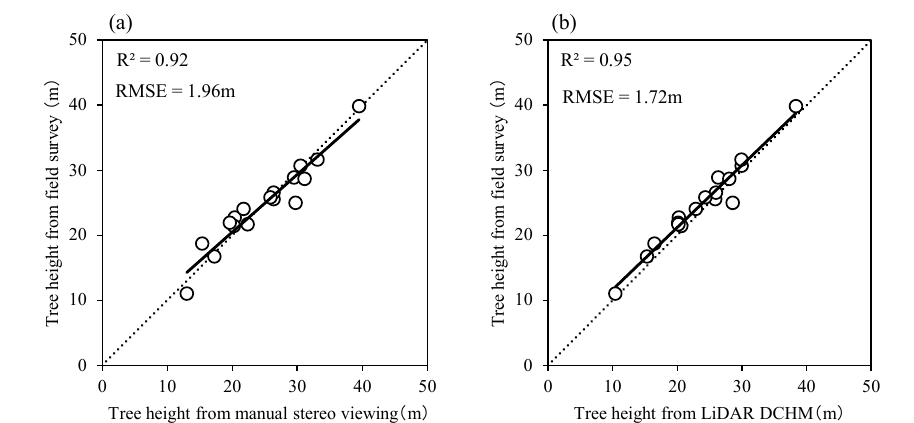
Figure 3. Result of tree height measurement in manual stereo viewing and DCHM from LiDAR. ( a ) Manual stereo viewing; ( b ) DCHM from LiDAR